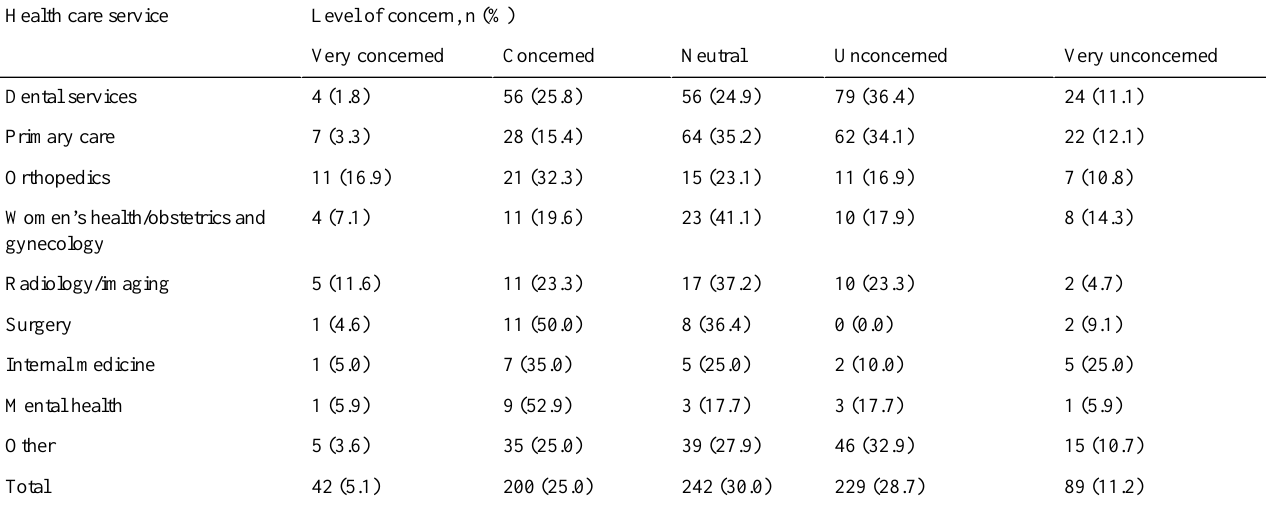
Table 4. Level of concern about care delays overall and by service line among 803 survey respondents in Vermont between April 30 and May 13, 2020, who reported deferring care due to the COVID-19 pandemic medical services shutdown.